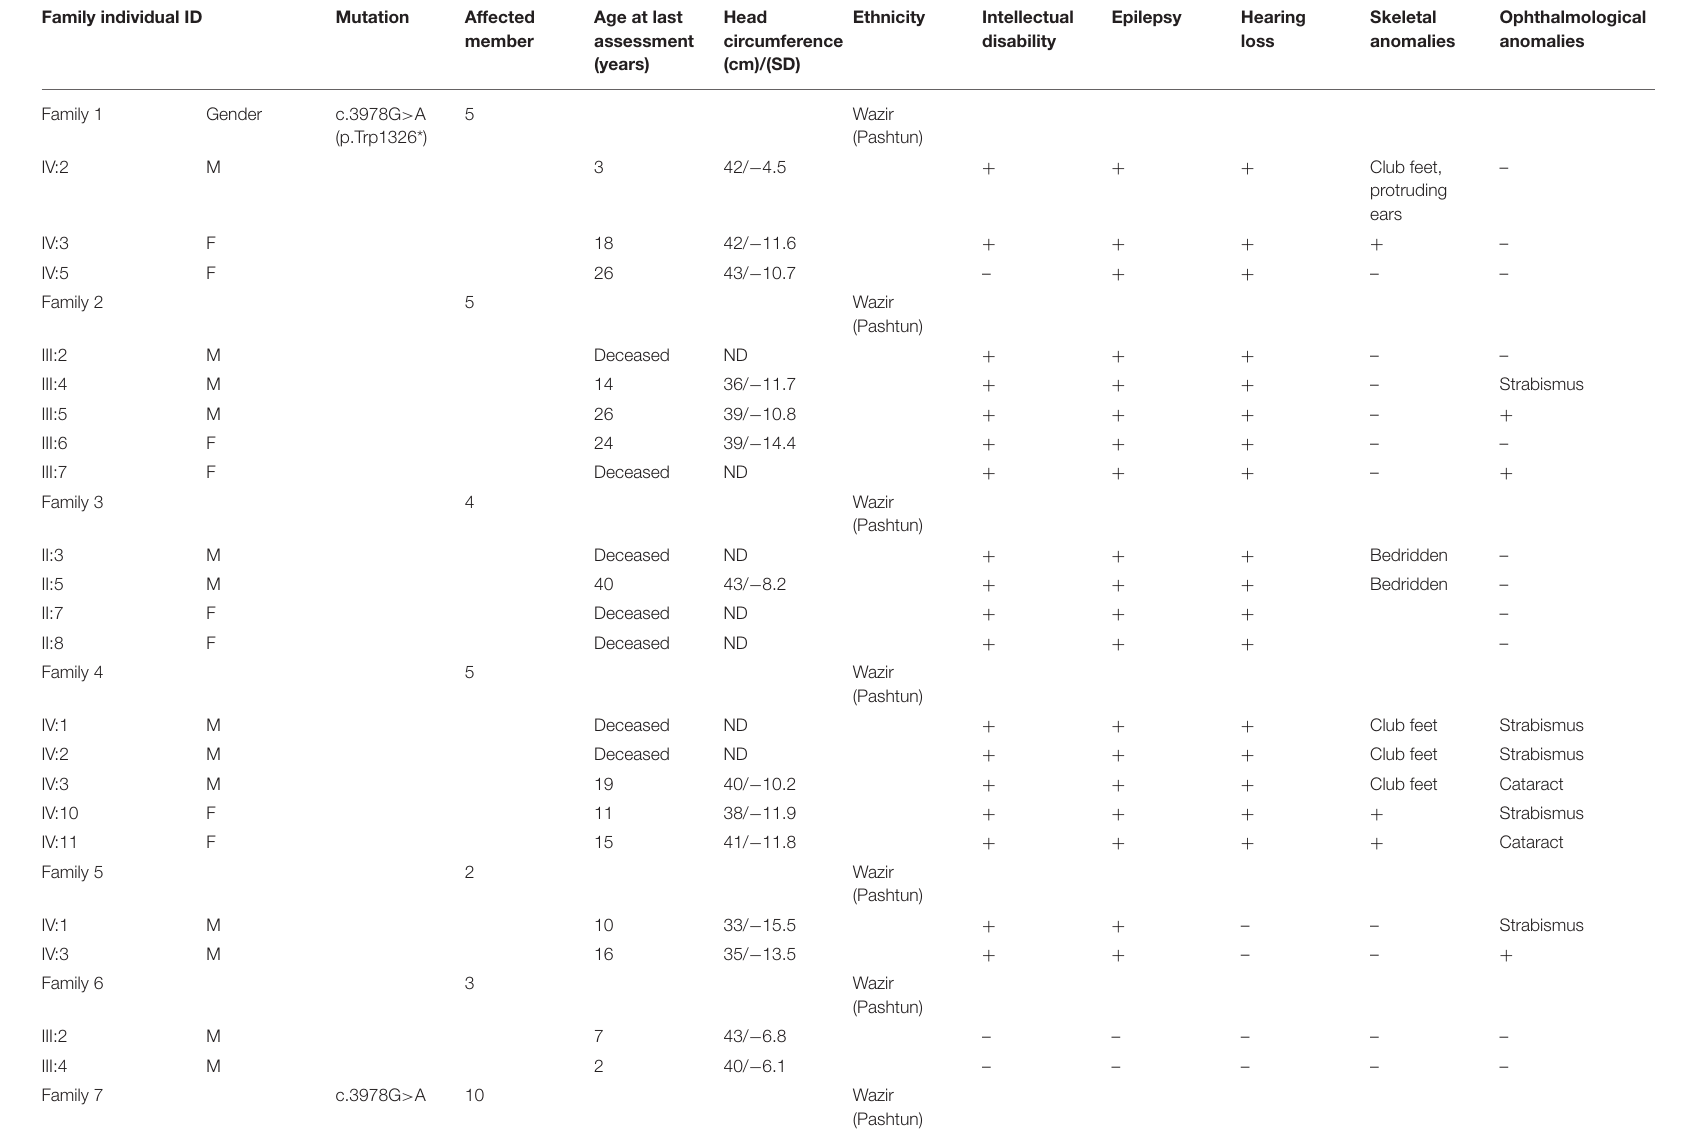
TABLE 1 | Clinical and genetic manifestations in the MCPH cohort. Family individual